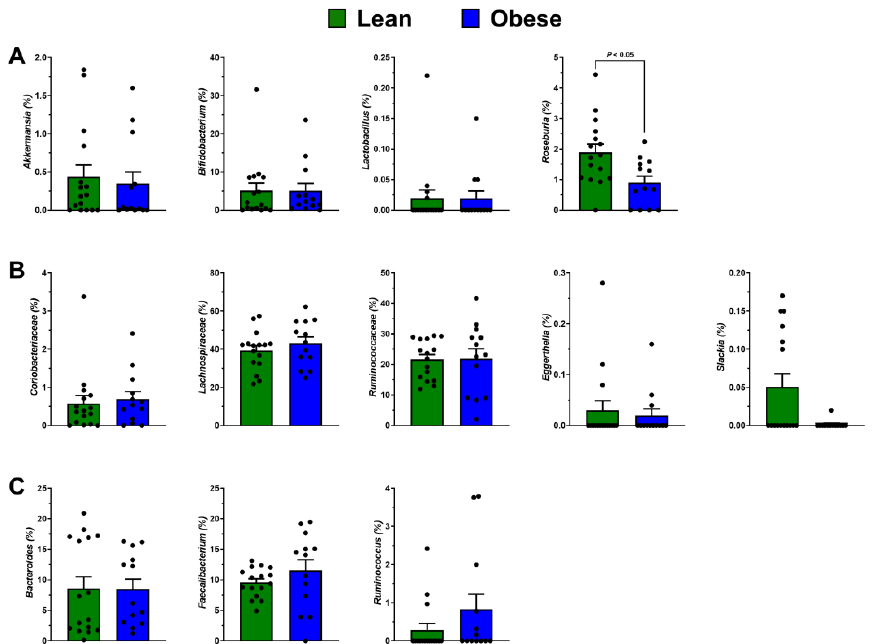
Figure 5. Relative abundances of family- and genus-level taxa between obese and lean individuals. Relative abundances (means ± SEM, n = 13 to 16 per group) of ( A ) Akkermansia , Lactobacillus , Bifidobacterium , and Roseburia , ( B ) Coriobacteriaceae , Lachnospiraceae , Ruminococcaceae , Eggerthella , and Slackia , and ( C ) Bacteroides , Faecalibacterium , and Ruminococcus between obese and lean individuals. Slackia was detected in too few of the participants ( n ≤ 6 per group) to reliably conduct statistical analysis. Data were analyzed using QIIME2 (version 2019.10 obtained from http://qiime.org accessed 30 September